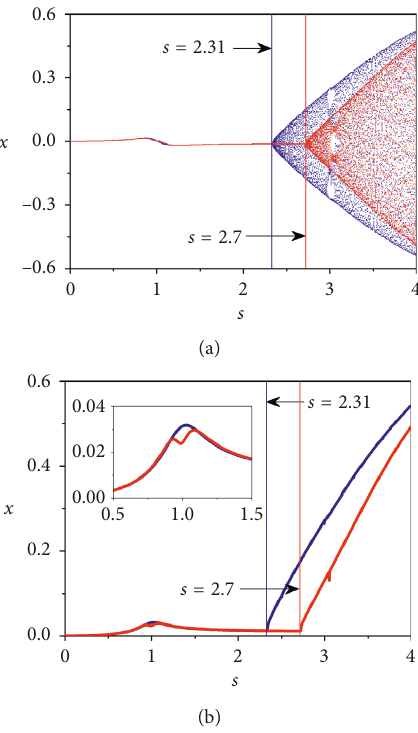
Figure 16: (a) The bifurcation diagram and (b) the amplitude- frequency response curve of the rotor/seal system attached with the DVA in the x coordinate when ζ a